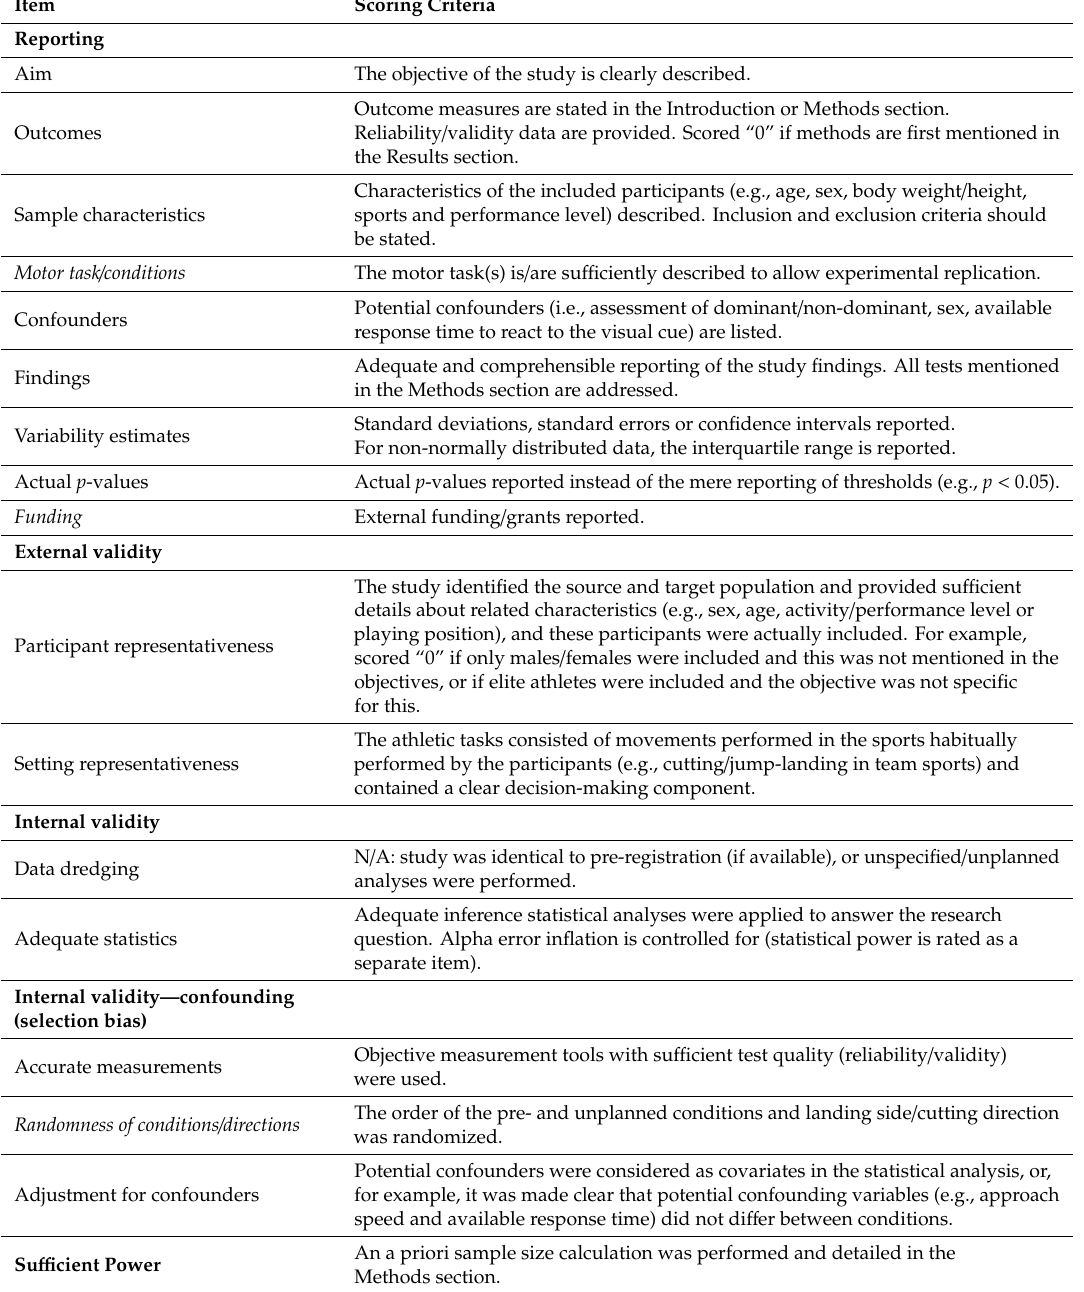
Table 2. The adapted checklist used for the scoring of methodological quality / risk of